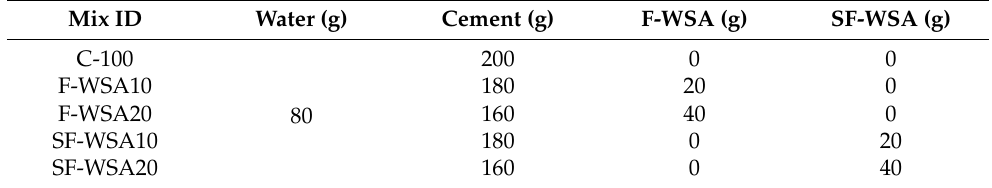
Table 5. Mixture proportion of control and other cement pastes containing F-WSA and SF-WSA. Mix ID Water (g) Cement (g) F-WSA